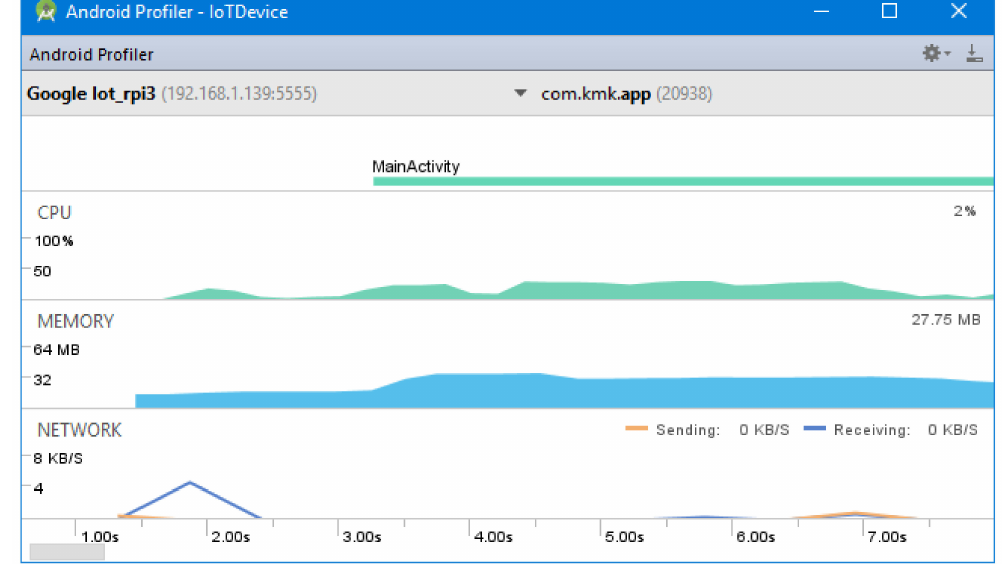
Figure 15. OCF device monitoring of registration and recursive sensing data collecting.